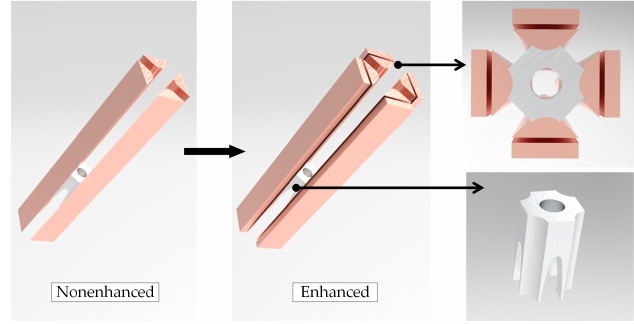
Figure 1. The 3D structure diagram.